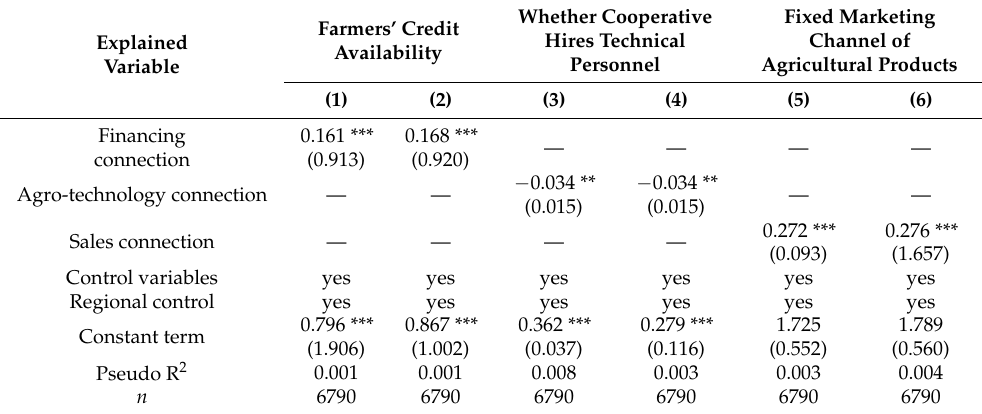
Table 5. Mitigation mechanisms of financing, agro-technology, and sales connection on material and ability poverty of